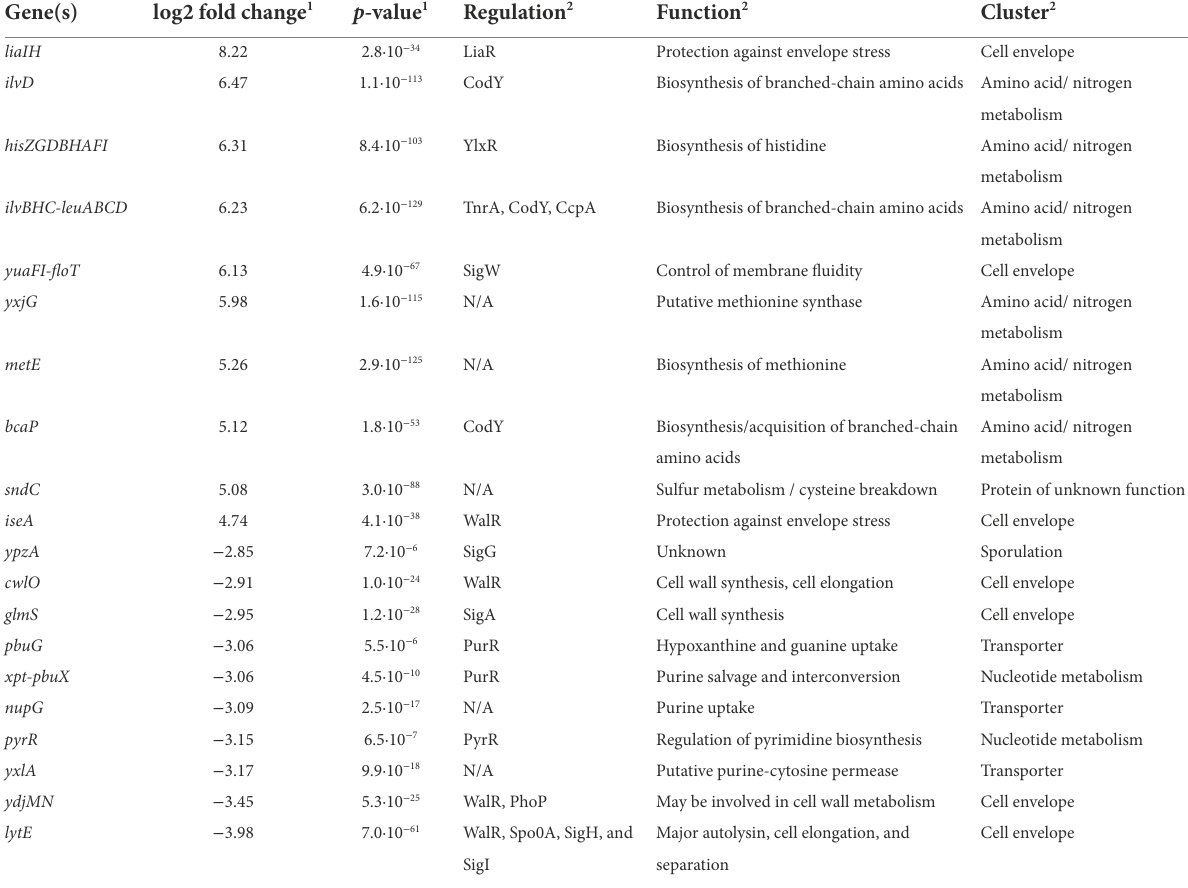
TABLE 2 Selection of the RNA-seq profile of differential expressed genes in B. subtilis upon BDTL049 exposure. Gene(s) log2 fold change 1